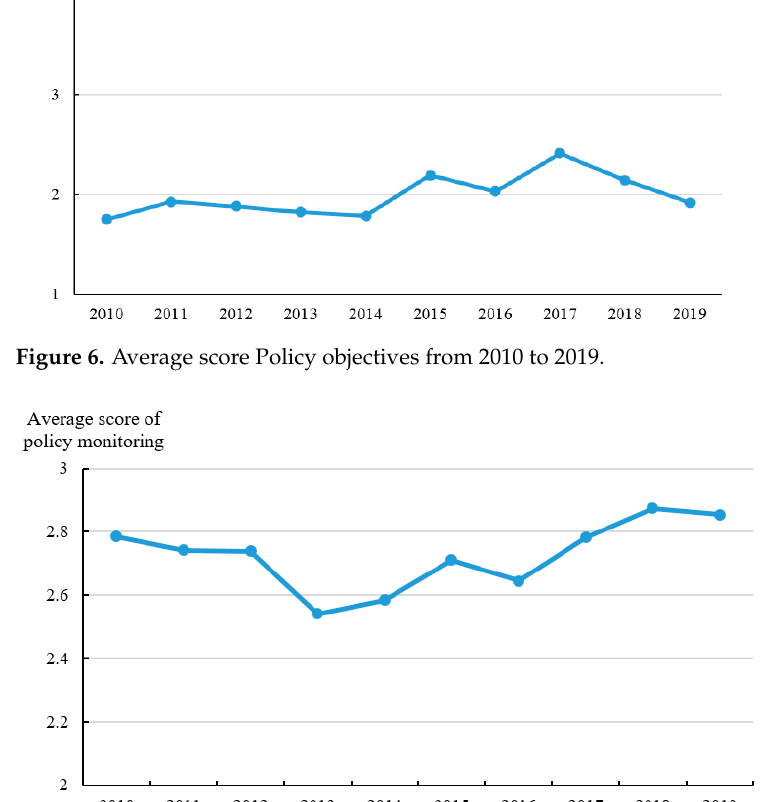
Figure 8. Average strength of policy with four types of measures from 2010 to 2019. 4.3. The ANPS Pollution and Policy Strength According to the calculation results in this paper, ANPS pollution emissions and pol- icy strength in different provinces are quite different. Considering the lag of policy effects, we report the policy strength in 2018 and ANPS pollution emissions in 2019 in 31 prov- inces of China in Figure 9.